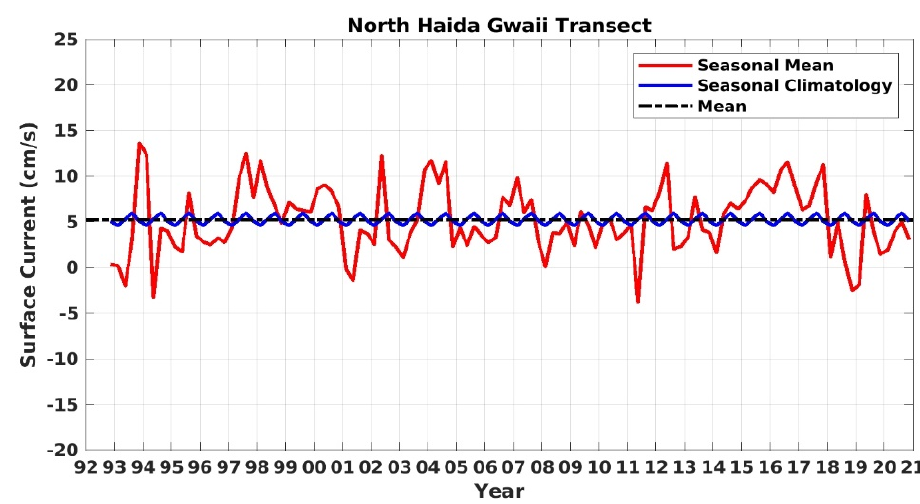
Figure 8. Same as Figure 3 but at the North Haida Gwaii Transect.